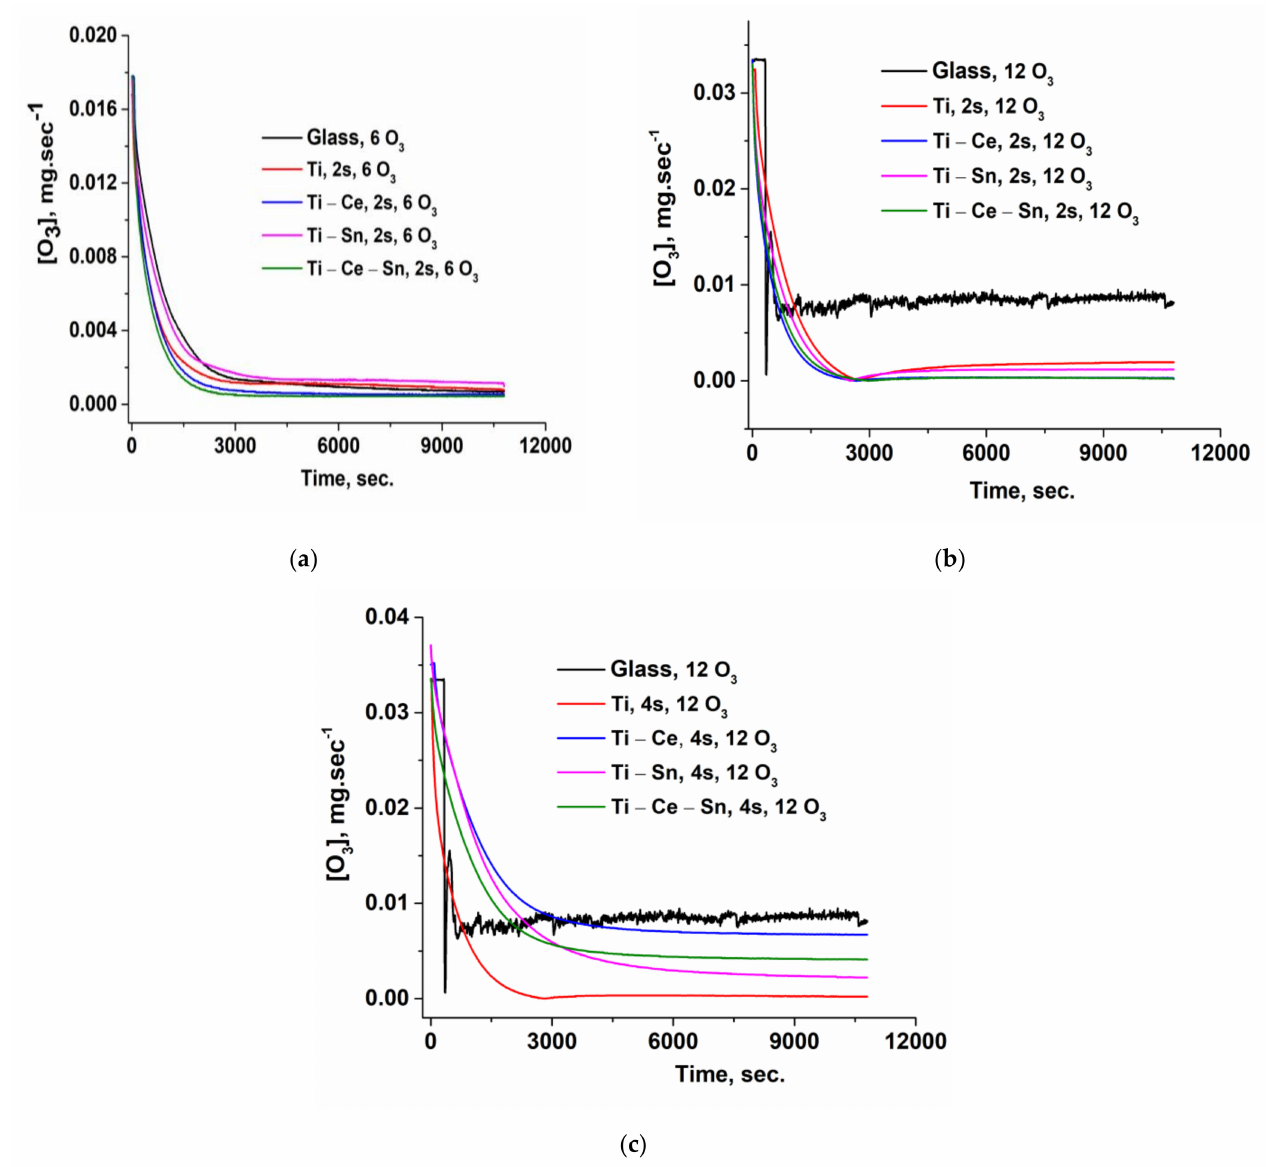
Figure 12. ( a ) Ozone concentration evolution in time for a lower ozone input and two slides; ( b ) Ozone concentration evolution in time for a higher ozone input and two slides; ( c ) Ozone concentration evolution in time for a higher ozone input and four